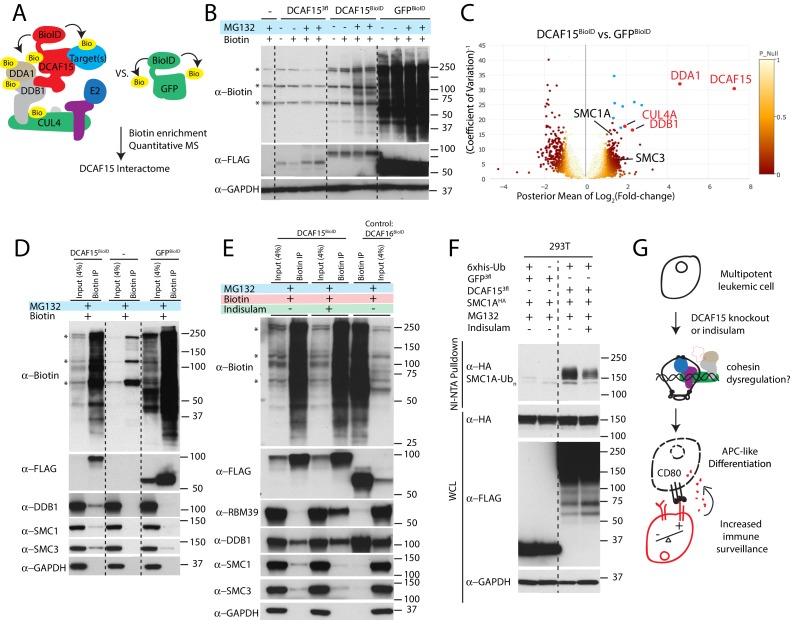
Cohesin complex members are CRL4-DCAF15 E3 ligase client proteins.(A) Experimental system for discovering DCAF15 interaction partners by proximity ligation. (B) Indicated constructs were stably expressed in K562 cells, and biotinylated proteins detected by HRP-conjugated streptavidin (‘α-biotin’). Asterisks denote major endogenous biotin-containing proteins. ‘MG132’ and ‘Biotin’ refer to 18 hr treatment with 5 μM MG132 or 50 μM biotin. (C) Proteins identified by quantitative mass spectrometry as differentially biotinylated by DCAF15-BioID as compared to GFP-BioID. Log2-fold changes are plotted against precision of the measurement (1/coefficient of variation). Colors denote the posterior probability that a protein fold change was small (referred to as ‘P-null’ in the legend), as explained in the Materials and methods. Data points in red are select CRL4 core complex members. Data points in blue are endogenous biotin-containing proteins. (D-E) Affinity capture of biotinylated proteins by streptavidin beads (‘biotin IP’) and detection by western blot. Indicated constructs were stably expressed in K562 cells. ‘Indisulam’ refers to 48 hr 0.1 μM indisulam treatment prior to MG132 and biotin addition. (F) Capture of 6xhis-ubiquitinated species by nickel chromatography under denaturing conditions and detection by western blot. The indicated expression plasmids were transiently transfected into 293 T cells. Input samples were prepared from whole cell lysates (WCL). ‘MG132’ and ‘Indisulam’ refer to 12 hr treatment with 10 μM MG132 or 2 μM Indisulam prior to harvest. G)Model of DCAF15 function.